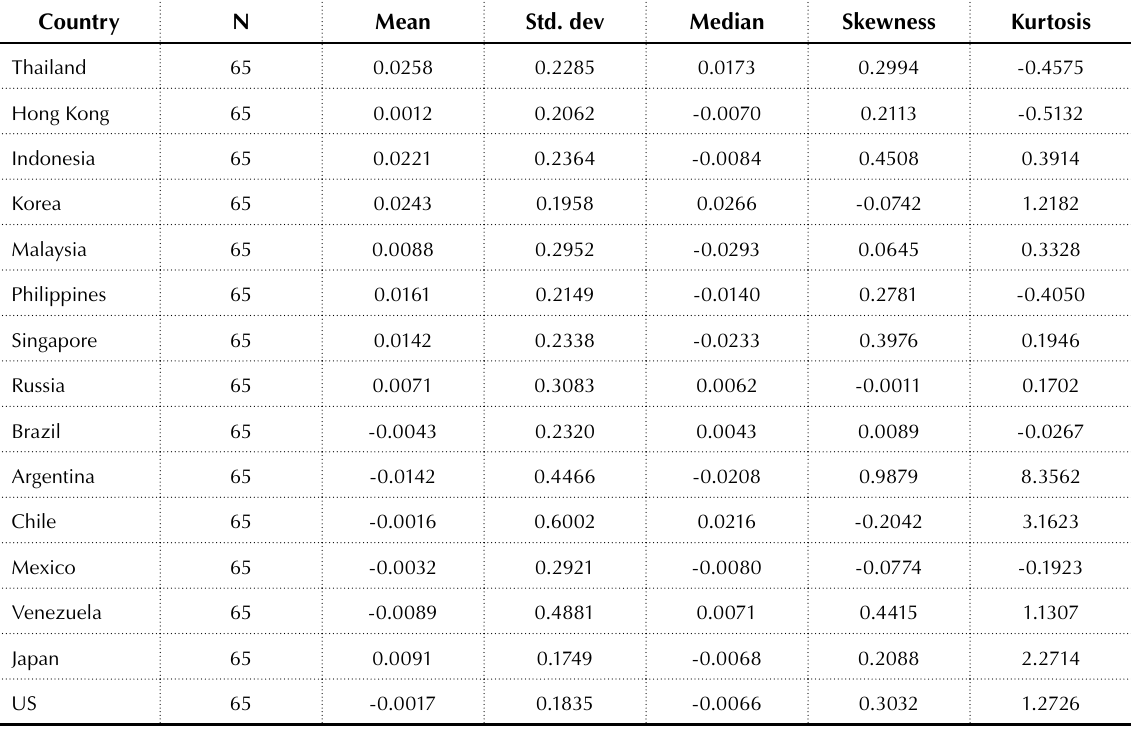
Table 1 (cont.). Summary statistics Panel B – Hong Kong crisis